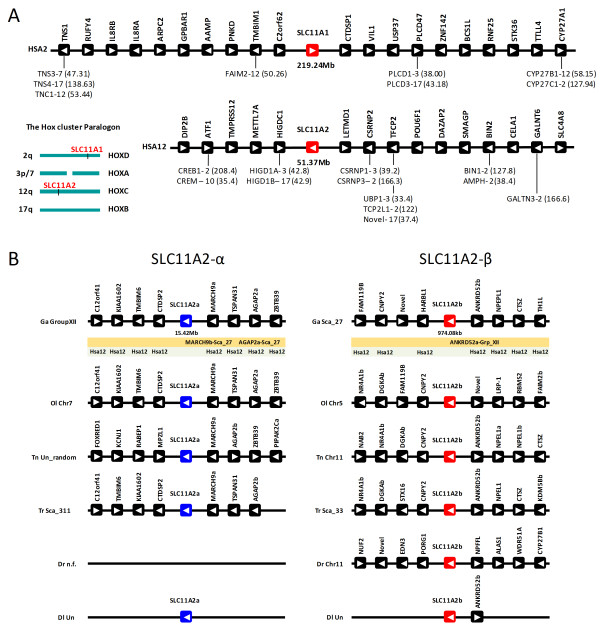
Chromosomal location of the human SLC11A1 and SLC11A2 genes (A) and SLC11 gene loci in teleost species (B). (A) Paralogs of gene families with multiple members are shown below each ORF, with distance in Mb to the p telomere of the respective chromosome. (B) Below the G. aculeatus loci, the location of teleost specific 3R paralogs is shown; also the genomic mapping position of human orthologs is presented. Ga - Gasterosteus aculeatus, Dr - Danio rerio, Ol - Oryzias latipes, Tn - Tetraodon nigroviridis, Tr - Takifugu rubribes, Dl - Dicentrarchus labrax. Arrows denote gene orientation.